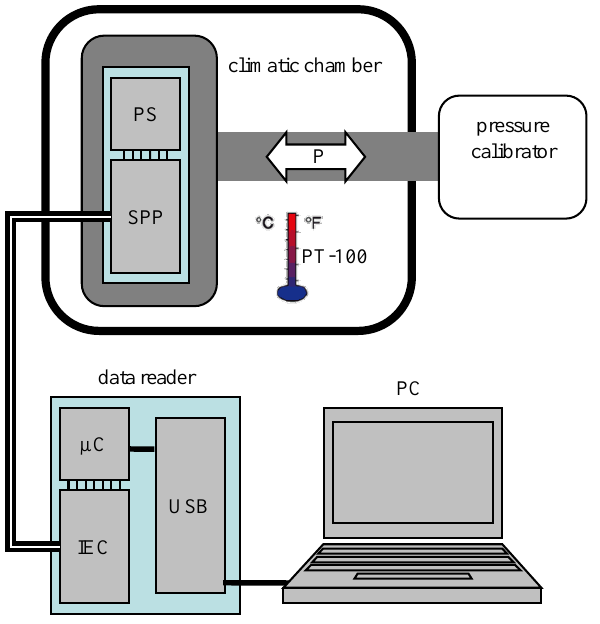
Figure 17. Overview of the pressure measurement system.